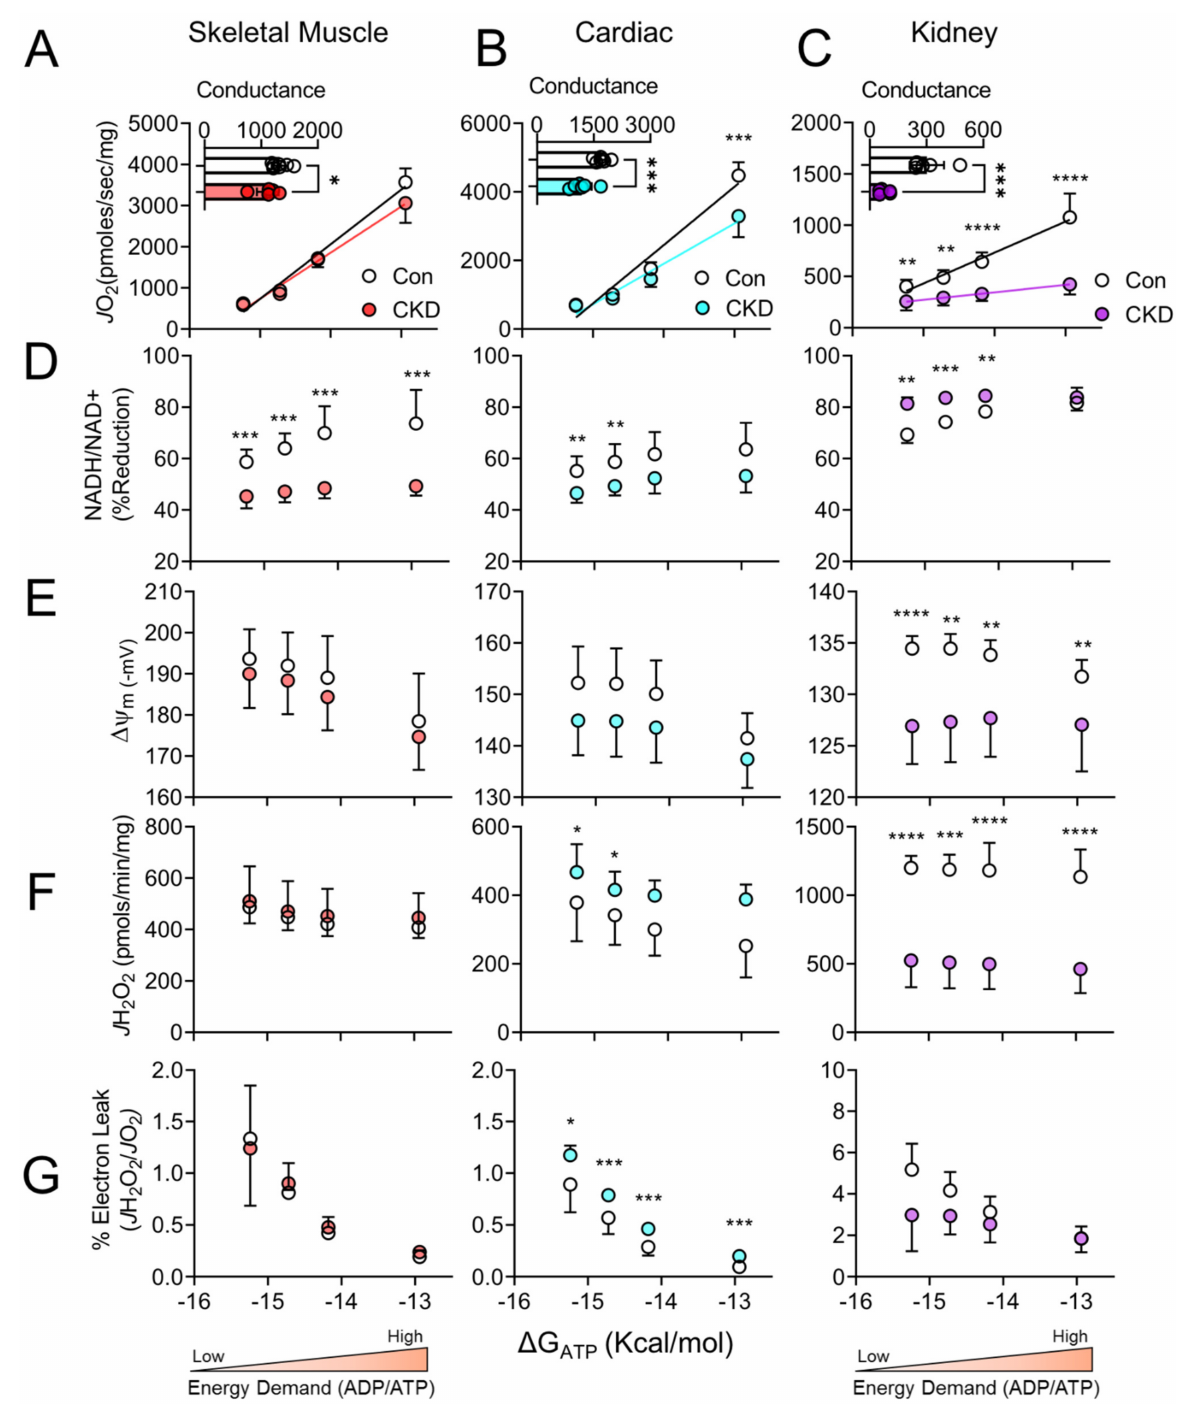
Figure 3. CKD negatively impacts energy transduction in skeletal muscle, cardiac muscle, and renal mitochondria. Mitochondria were isolated from skeletal muscle, cardiac muscle, and the kidney obtained from control and CKD mice. ( A – C ) Physiological assessment of mitochondrial OXPHOS was employed to mimic a mitochondrial stress test at relevant levels of extramitochondrial energy demand to compare tissue energetics and conductance was quantified (slope of J O 2 vs. ∆ G ATP ) ( n = 6–7/group); ( D ) Relationship between NADH/NAD+ and NADPH/NADP+ redox state expressed as percentage reduction vs. Gibbs energy of ATP hydrolysis ( ∆ G ATP ); ( E ) mitochondrial membrane potential ( ∆Ψ ) in millivolts vs. ∆ G ATP ; ( F ) H 2 O 2 production vs. ∆ G ATP ; ( G ) mitochondrial electron leak plotted against ∆ G ATP in control and CKD mice ( n = 6–7/group). Data were analyzed using two-tailed unpaired t -test. Error bars show standard deviation. p < 0.05 *, p < 0.01 **, p < 0.001 ***, and p < 0.0001